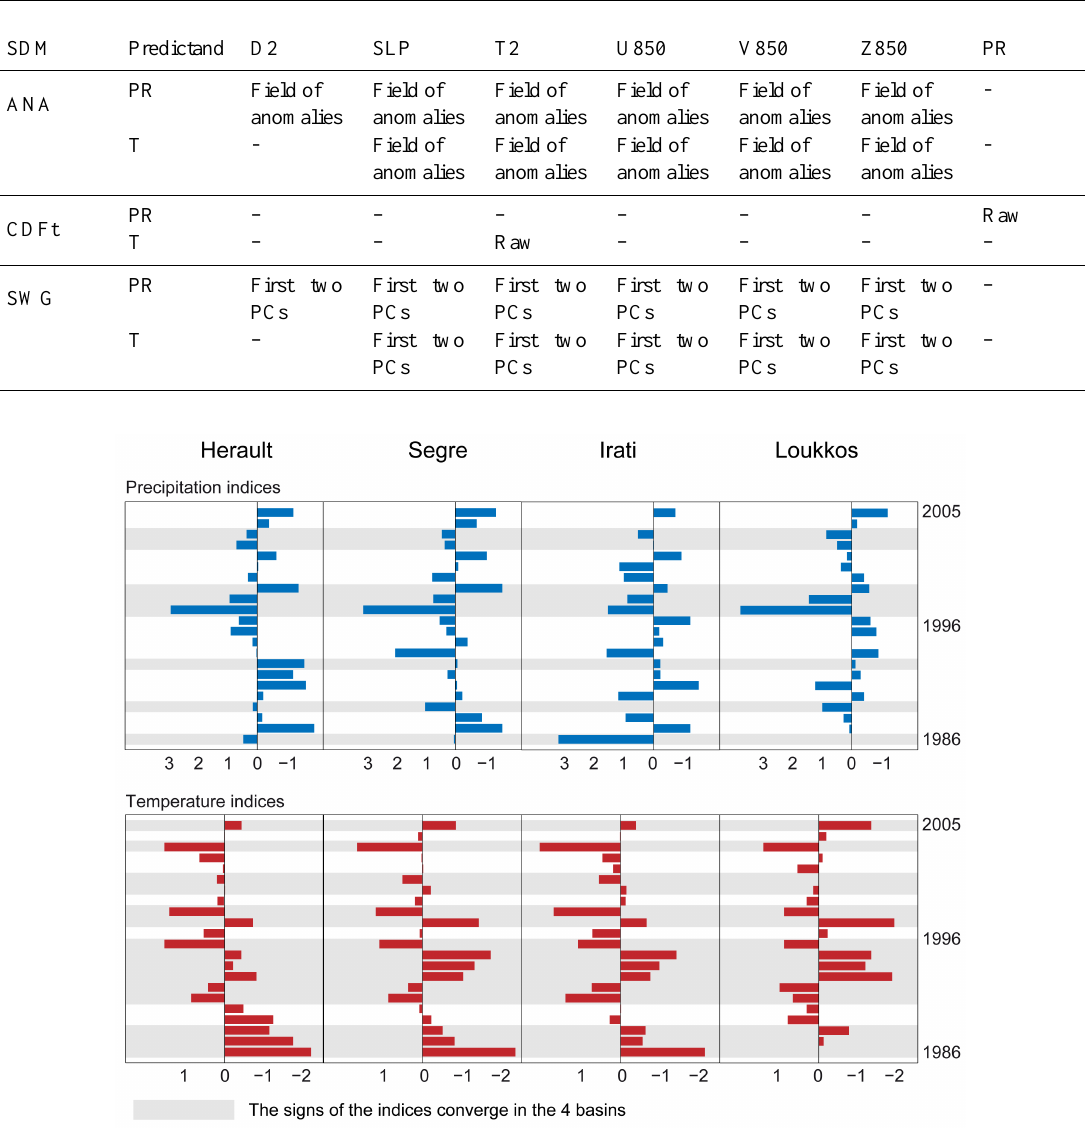
Figure 2. Precipitation ( I P = (P y − P y )/σ P ) and temperature ( I T = (T y − T y )/σ T ) indices applied to the four basins over the 1986–2005 period. The grey lines highlight years when the signs of the indices are the same for the four basins. P y is the annual precipitation for the year y, P y is the mean of the annual precipitation and σ P is the standard deviation of the annual precipitation. T y is the annual temperature for the year y, T y is the mean of the annual temperature and σ T is the standard deviation of the annual